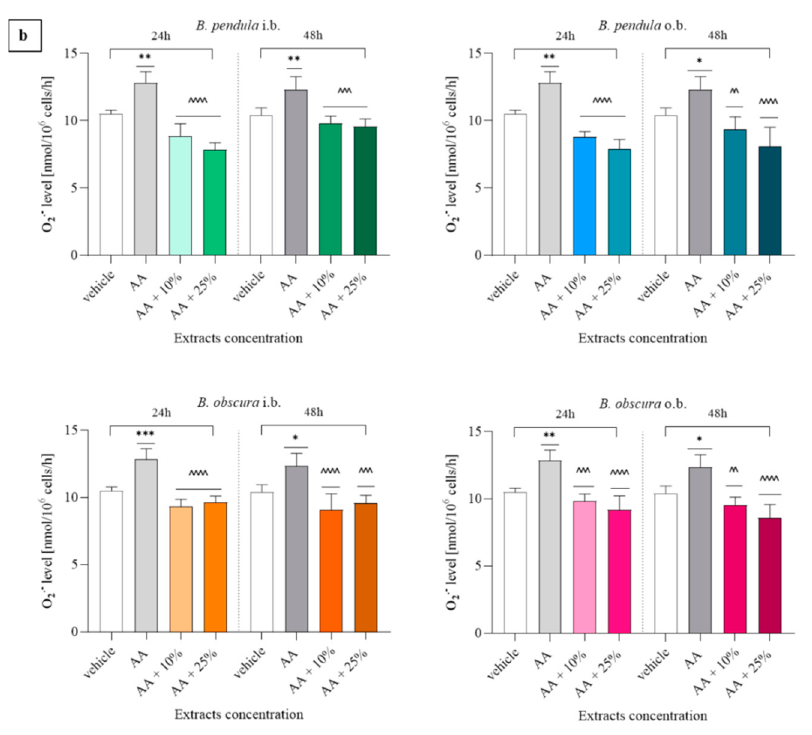
Figure 5. Evaluation of hydrogen peroxide ( a ) and superoxide anion radical ( b ) release from 24 h and 48 h incubation of L929 cell line with 10% and 25% extracts. Data presented as the means ± SD; * p < 0.05, ** p < 0.01, *** p < 0.0001, vs. vehicle group; ^^ p < 0.01, ^^^ p < 0.001, ^^^^ p < 0.0001 vs. AA group; Tukey’s test. Abbreviations: i.b., inner bark; o.b., outer bark; AA, acetaldehyde